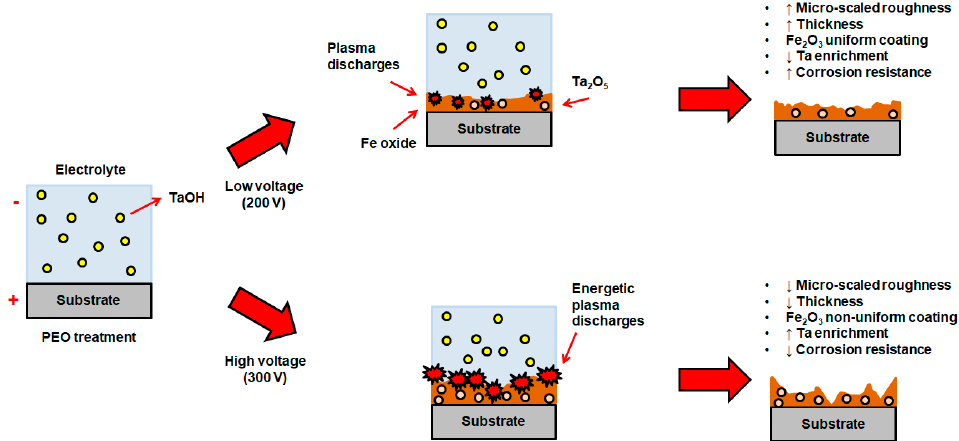
Figure 8. Schematic diagram of the PEO treatment on low-carbon steel substrate based on the results collected at low and high voltages.